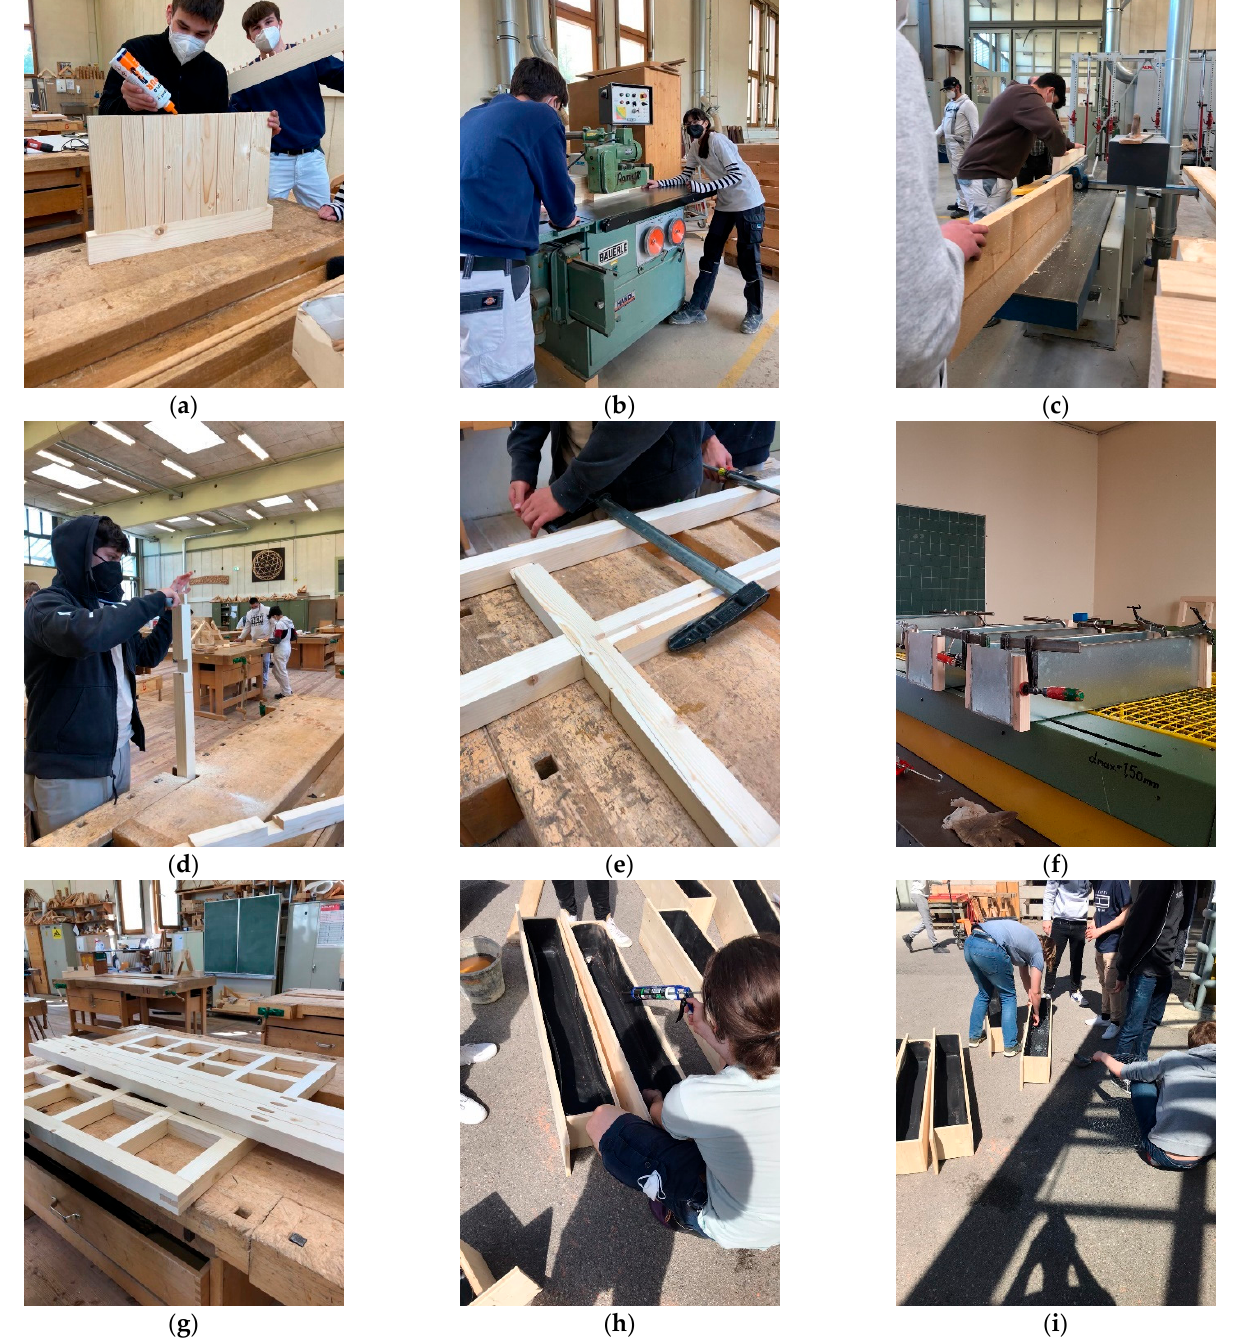
Figure 2. Construction of the prototypes of the indoor greening systems in May 2021 at the con- struction yard of the Camillo Sitte Bautechnikum in Vienna: ( a – c ) plantable seating furniture “Green Domino”; ( d – f ) plantable hanging system “Green Cloud”; ( g ) modular wall greening system; ( h , i ) plantable mobile partition.